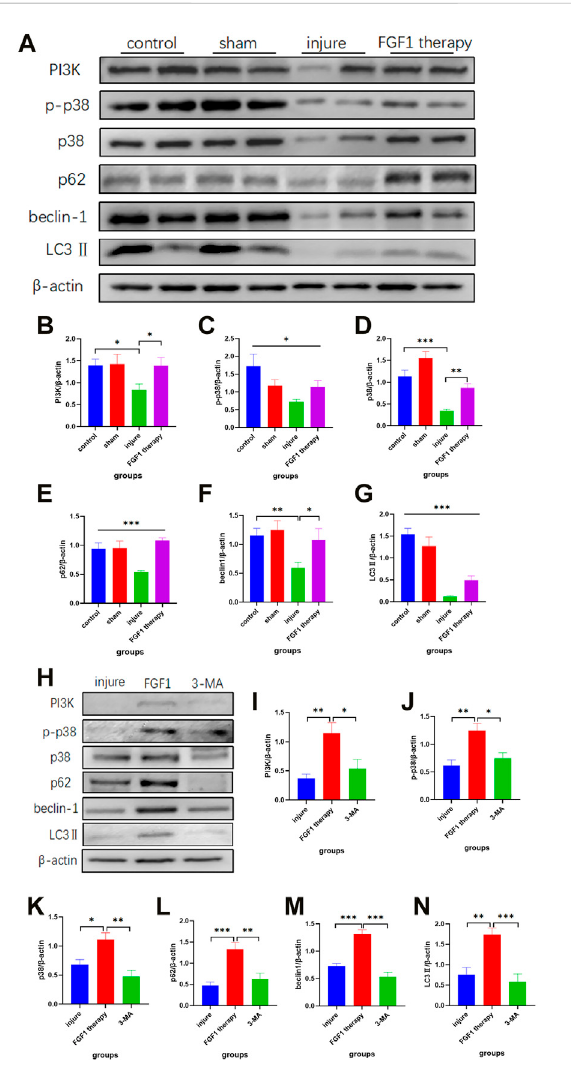
FIGURE 5 Endometrial repair by FGF1 is achieved mainly through activation of the PI3K/p38/Beclin 1 pathway. Trends in the expression of PI3K, p-p38, p38, p62/SQSTM1, beclin1 and LC3 Ⅱ indicator proteins after FGF1 treatment revealed by Western blot experiments (A) . Statistical analysis of the expression with PI3K (n = 6) (B) , p-p38 (n = 7) (C) ,p38(n=6) (D) ,p62/SQSTM1(n=8) (E) ,beclin1(n=8) (F) andLC3 Ⅱ (n = 8) (G) in Western blot. * p < 0.05, ** p < 0.01, *** p < 0.001. Intraperitoneal injection of 3-MA blocks protein expression of related pathways after activation of the autophagic pathway (H) . Statistical analysisoftheexpressionwithPI3K(n=6) (I) ,p-p38(n=8) (J) ,p38(n= 7) (K) , p62/SQSTM1(n = 6) (L) , beclin1 (n = 12) (M) and LC3 Ⅱ (n = 8)